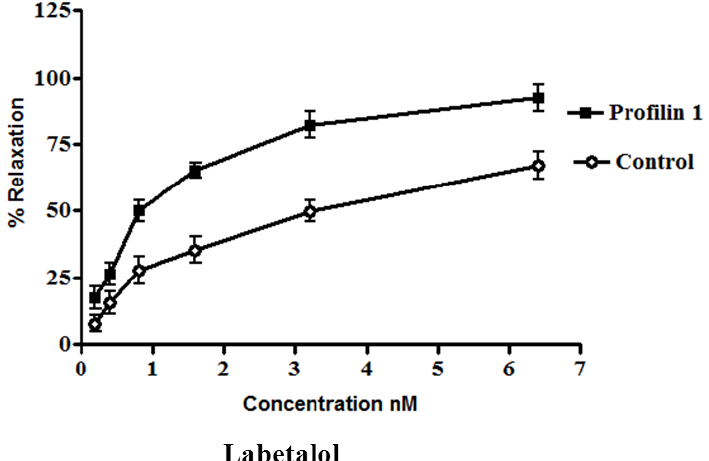
Figure 3. The effects of labetalol on vascular reactivity of profilin1 mesenteric arteries. Vascular reactivity of profilin1 and control mesenteric arteries (n = 8) was assessed towards labetalol at different concentrations using the myograph system. The results show a decrease in the relaxing responses in profilin1 mesenteric arteries compared to non-transgenic